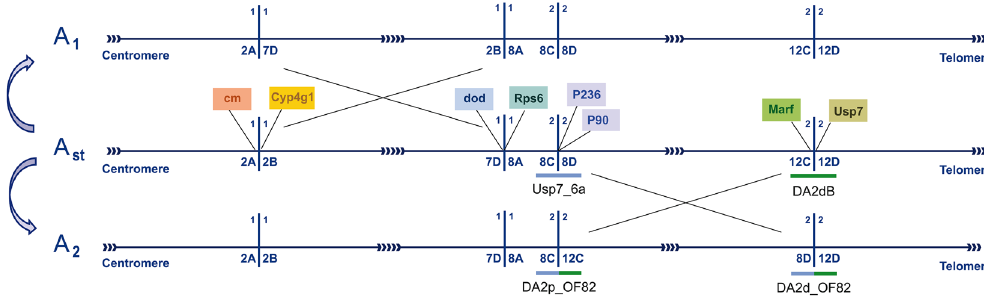
Figure 1. Schematic representation of the A chromosome regions of Drosophila subobscura affected by inversions A 2 and A 1 . Horizontal lines connected by arrows represent the different chromosomal arrangements —the A st arrangement in the center and the A 1 and A 2 arrangements above and below, respectively—, whereas vertical lines represent the different inversion breakpoints with indication of their location (section) on the Kunze-Mühl and Müller (1958) map. Pairs of crossed lines between arrangements indicate inverted regions. The location of the initial markers used for chromosomal walks are represented in colored boxes on the A st arrangement. Short blue and green horizontal lines represent the fragments spanning the A 2 inversion breakpoint regions with the name of the probes